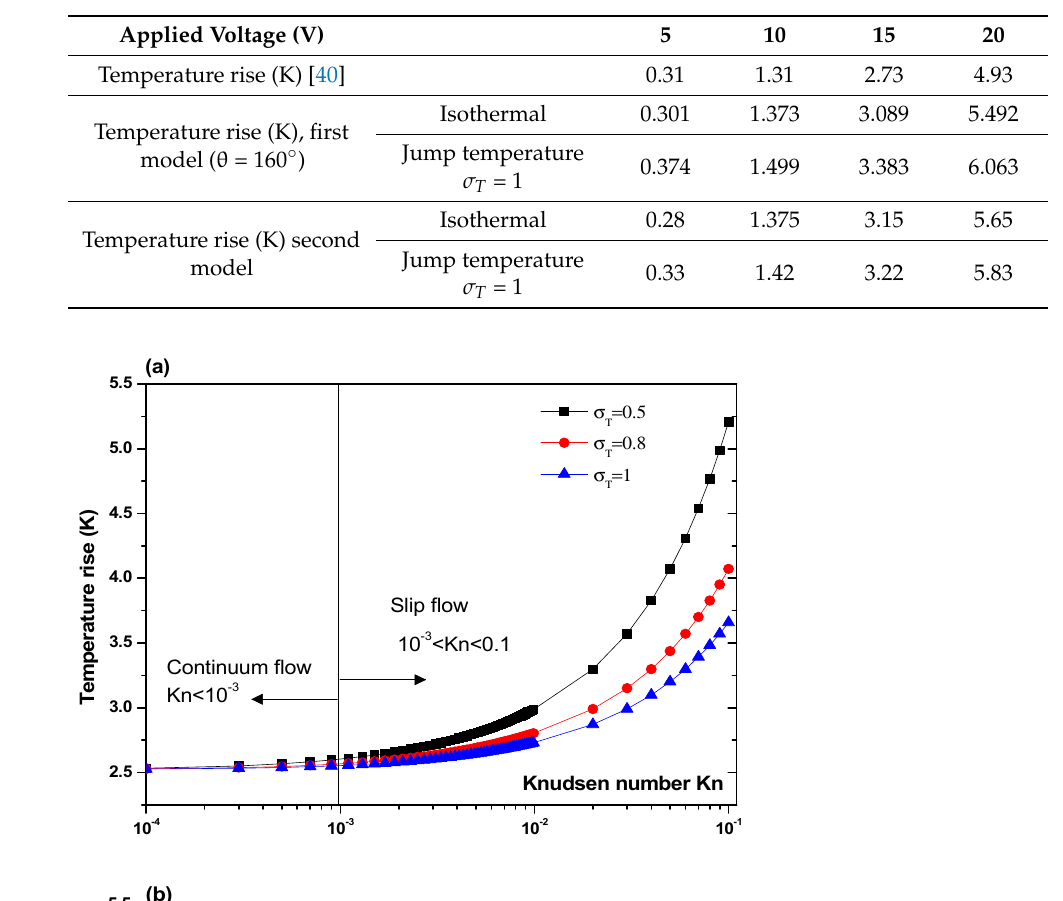
Table 3. Comparison of temperature rise with and without temperature jump with the results of Huang et al. [40].